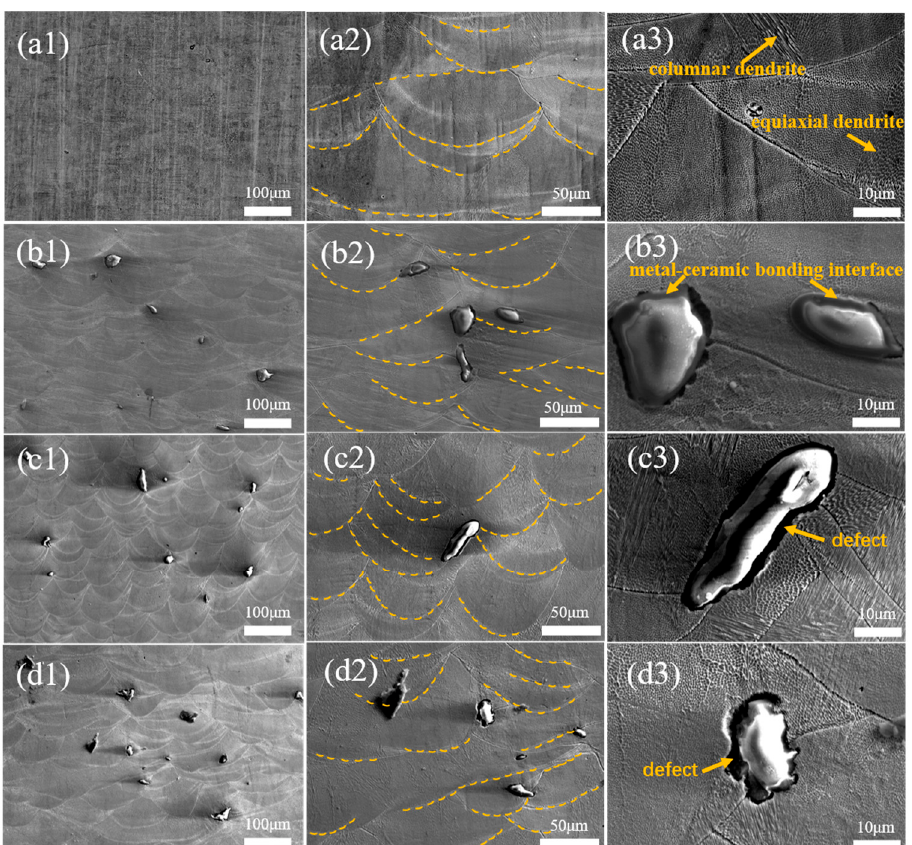
Figure 7 . SEM images of longitudinal section for the LPBF-processed parts: ( a1 – a3 ) CCM, ( b1 – b3 ) CCM@1Al 2 O 3 , ( c1 – c3 ) CCM@1.5Al 2 O 3 and ( d 1 – d 3 ) CCM@2Al 2 O 3 .